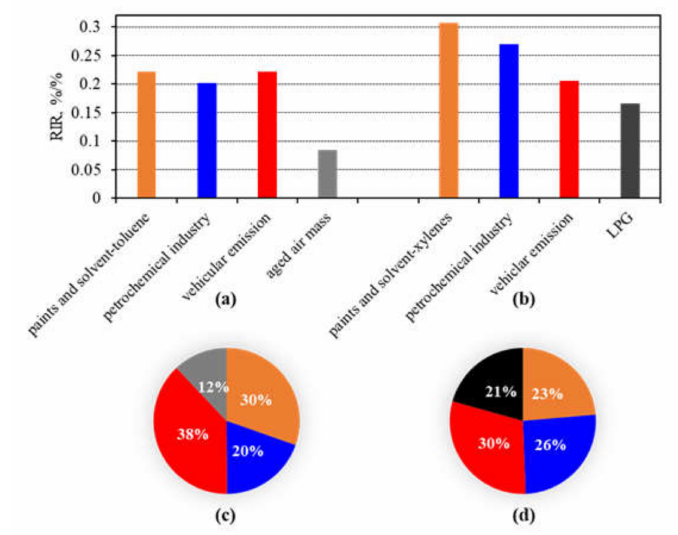
Figure 11. The RIR values for anthropogenic NMHCs from di ff erent PMF-resolved sources ( a ) at the DSH site and ( b ) the PD site, and relative contributions of di ff erent sources to O 3 formation ( c ) at the DSH site and ( d ) at the PD site during pollution episodes (11–16 July and 18–26